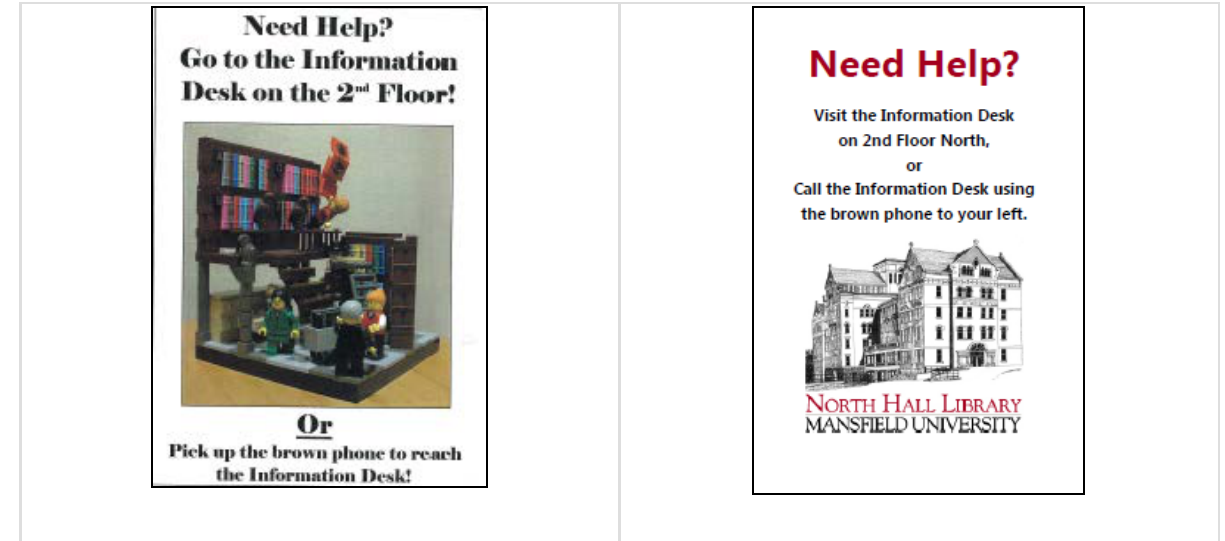
The original sign (left) uses a font that can be difficult to read at a distance, a photo that is distracting, and contrast that is not effective. The new version (right) is clearer because of better contrast. It could benefit from an even larger